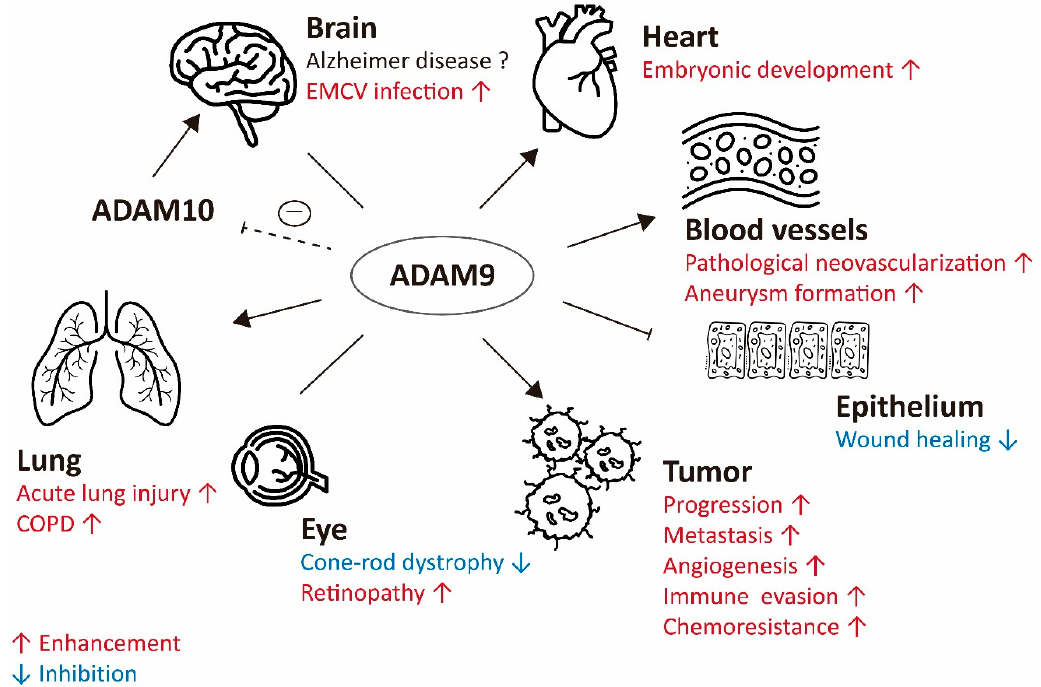
Figure 2. The role of ADAM9 in various pathophysiological conditions. Brain: ADAM9 acts as an α -secretase to reduce the risk of Alzheimer’s disease, but it can reduce the proportion of membrane-anchored ADAM10 and results in reduced α -secretase activity of ADAM10. Therefore, ADAM9 has